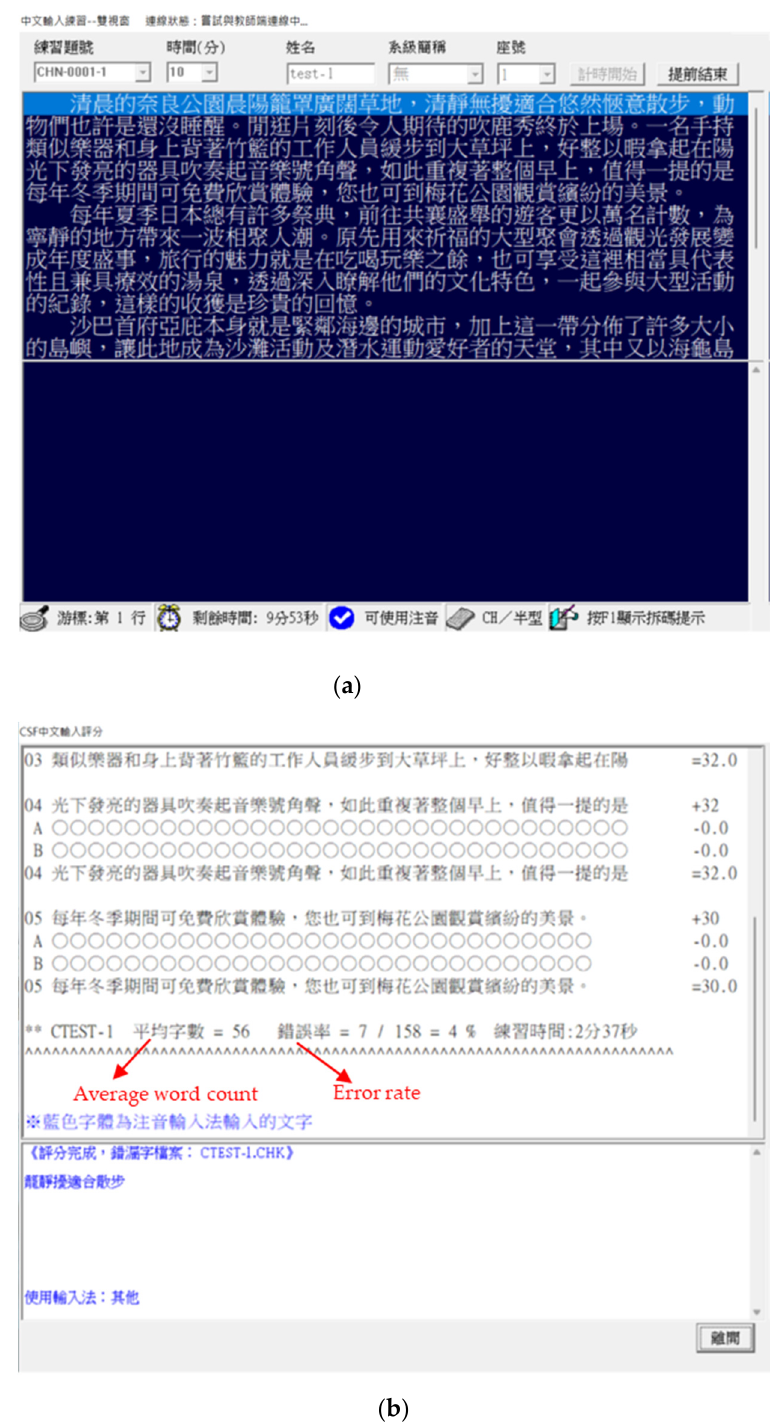
Figure 6. Biological physiological characteristic information collection equipment wGT3X-BT ( a ) The WGT3x-BT wrist meter host of ActiGraph; ( b ) ActiLife analysis software provided by Acti- Graph.